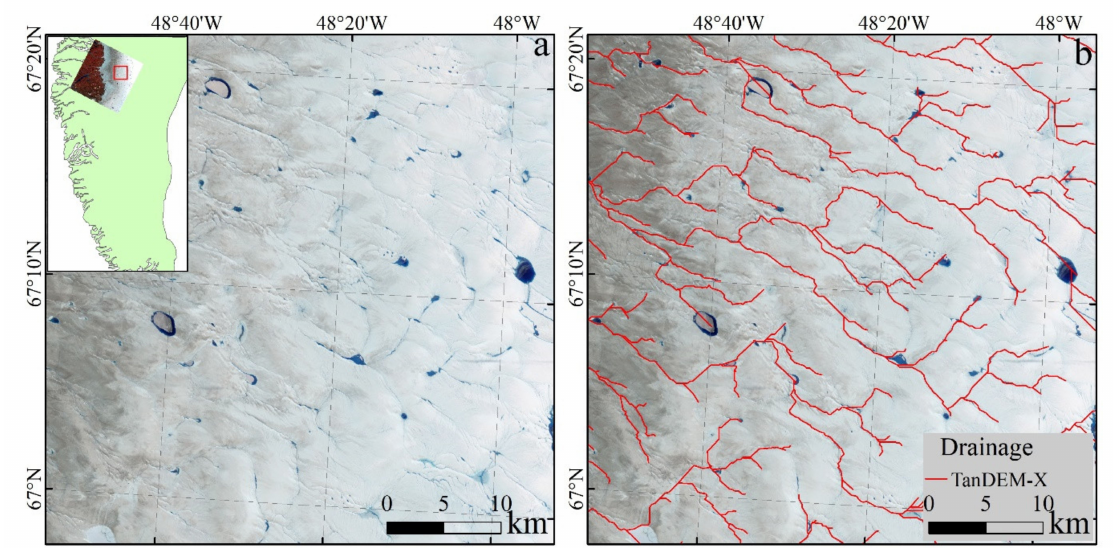
Figure 9. Verification of the TanDEM-X river network extraction result. The basin name of the inset map is the Southwest basin. Panel ( a ) is the distribution of the actual river network, and panel ( b ) is the river network extraction result for the TanDEM-X product. The background image is from Landsat-8 and was acquired on August 6, 2014. River network information on the fused image is not obvious, so the fused image is enhanced.